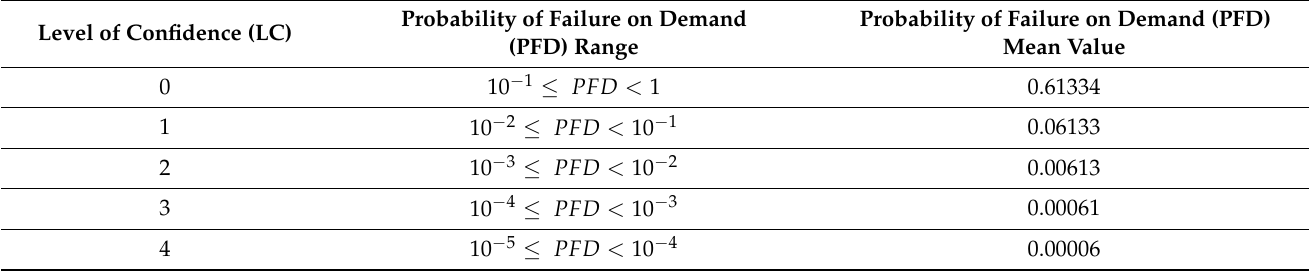
Table 1. Quantitative Level of Confidence assessment [29].